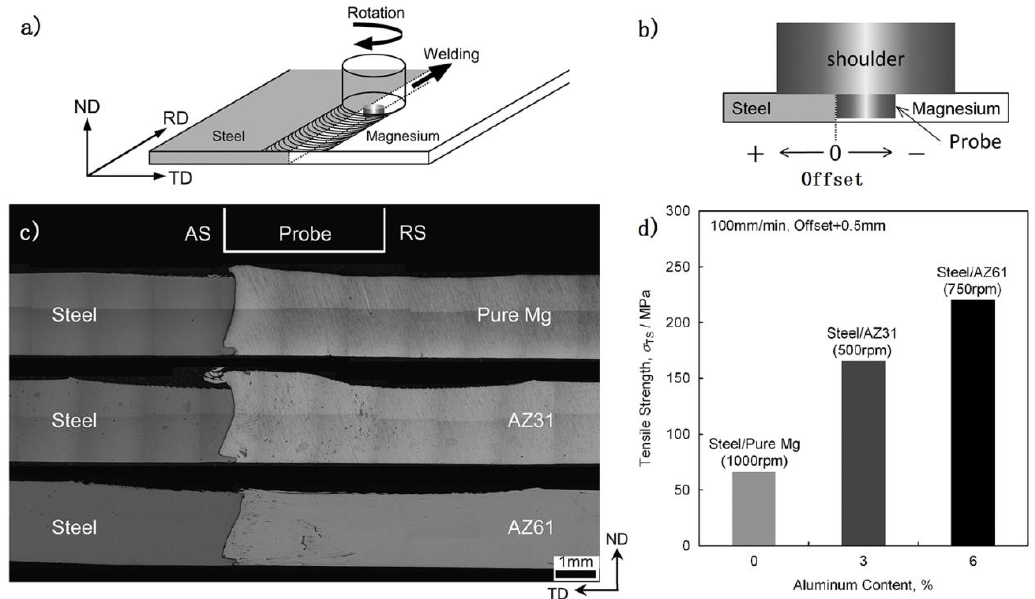
Figure 5. FSW Mg/steel butt joint process [22] ( a ) schematic illustrations; ( b ) tool offset position; ( c ) OM images of the interfaces on the cross section; ( d ) relationship between the optimal tensile strength of the joint and Al content.